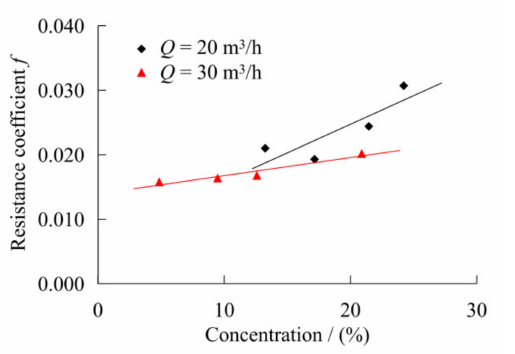
Figure 10. The influence of sediment concentration on the resistance